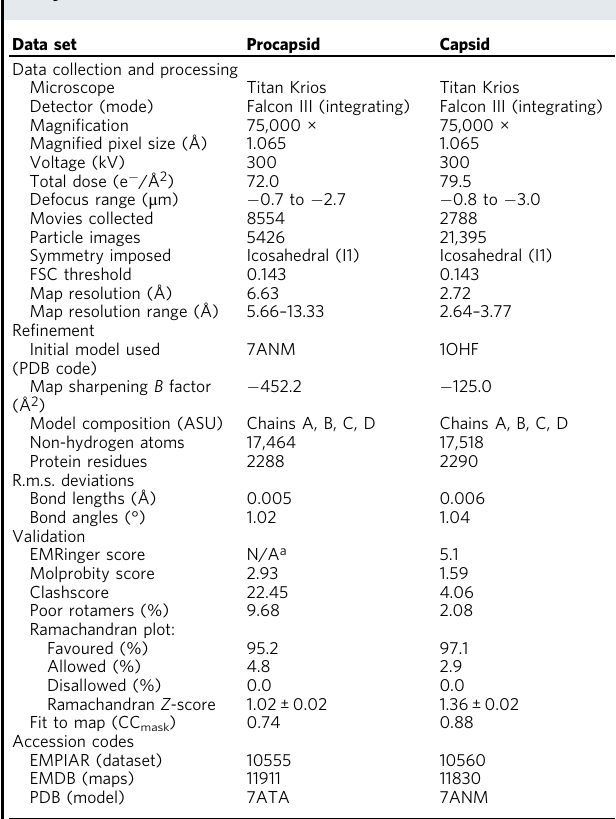
Table 1 Summary of cryo-EM data collection, processing and analysis.